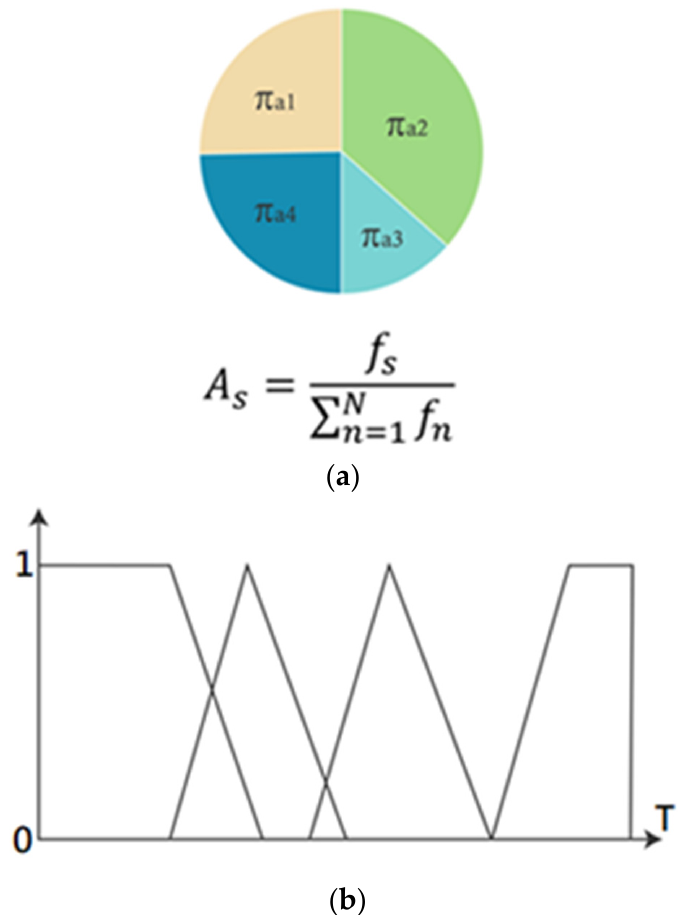
Figure 2. A revised model of the fuzzy roulette selection method. ( a ) Area of the roulette wheel, ( b ) The fuzzy